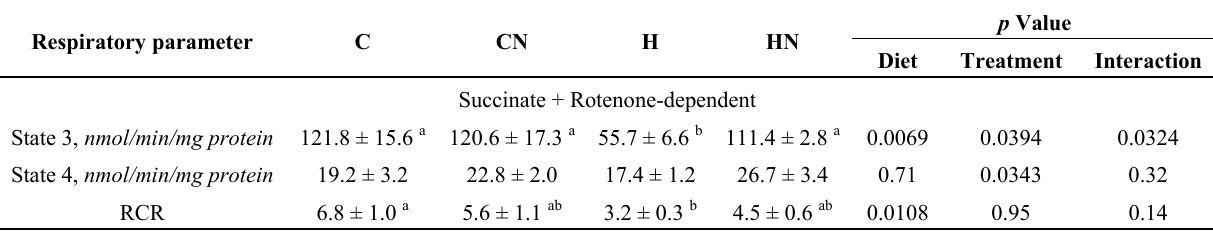
Table 4. Succinate-dependent respiratory parameters of isolated liver mitochondria. Respiratory